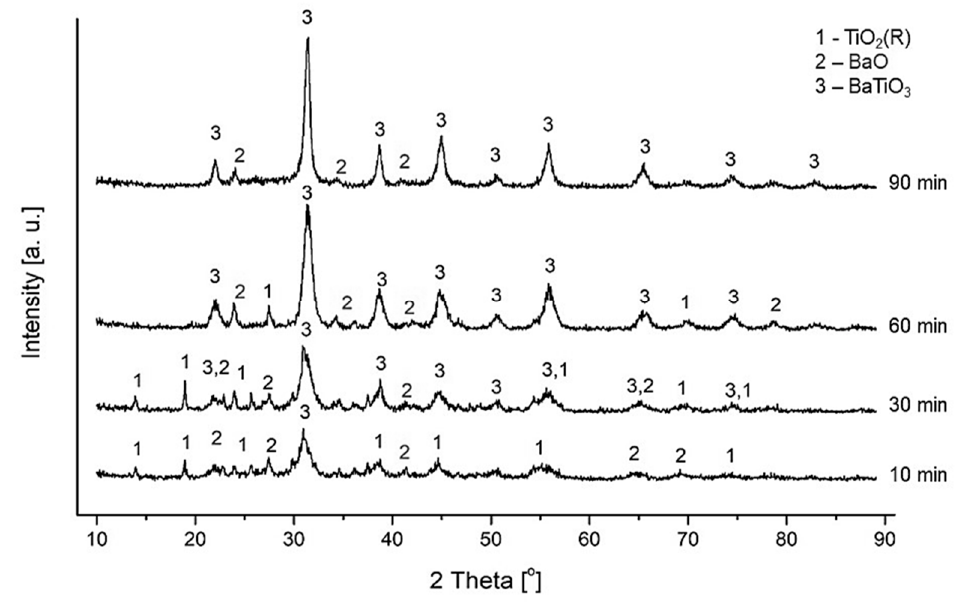
Figure 3. XRD patterns of mechanochemically synthesized barium titanate.